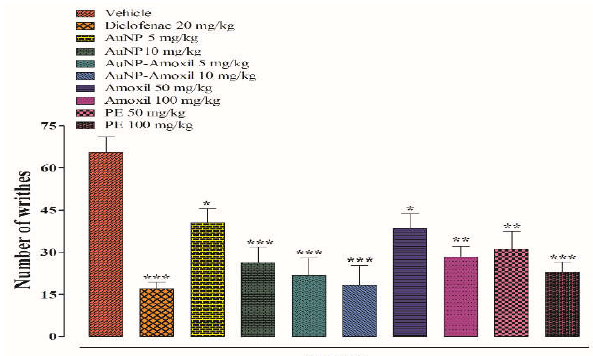
Figure 8. Chemically induced antinociceptive pain (writhing test). Bars represent mean ± SEM. * p < 0.05, ** p < 0.01, *** p < 0.001 compared to the vehicle treated animals. Data were analyzed by one-way ANOVA followed by Tukey’s test.